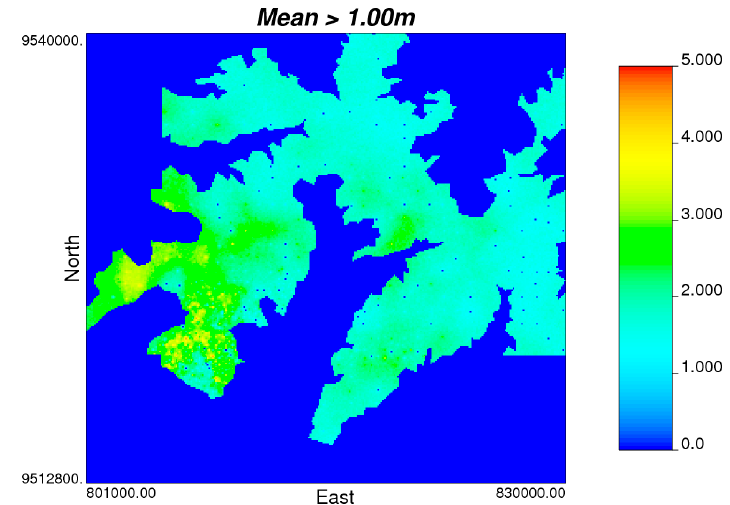
Figure 15. Map with average thickness greater than 1.00 m.